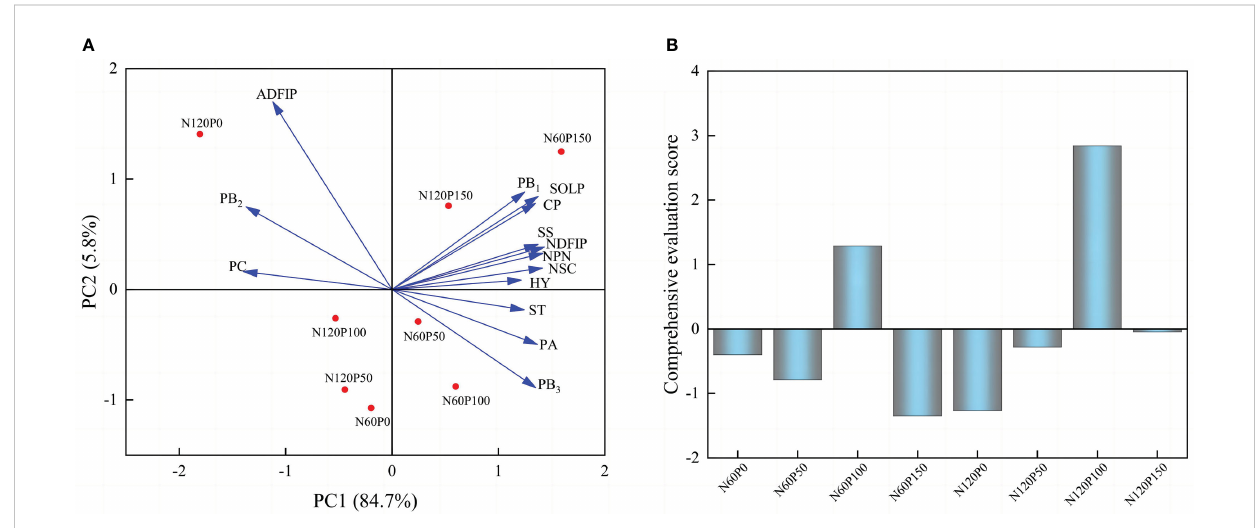
FIGURE 7 Principal component analysis of protein fractions and non-structural carbohydrates of alfalfa. (A) Principal component analysis, (B) Comprehensive evaluation